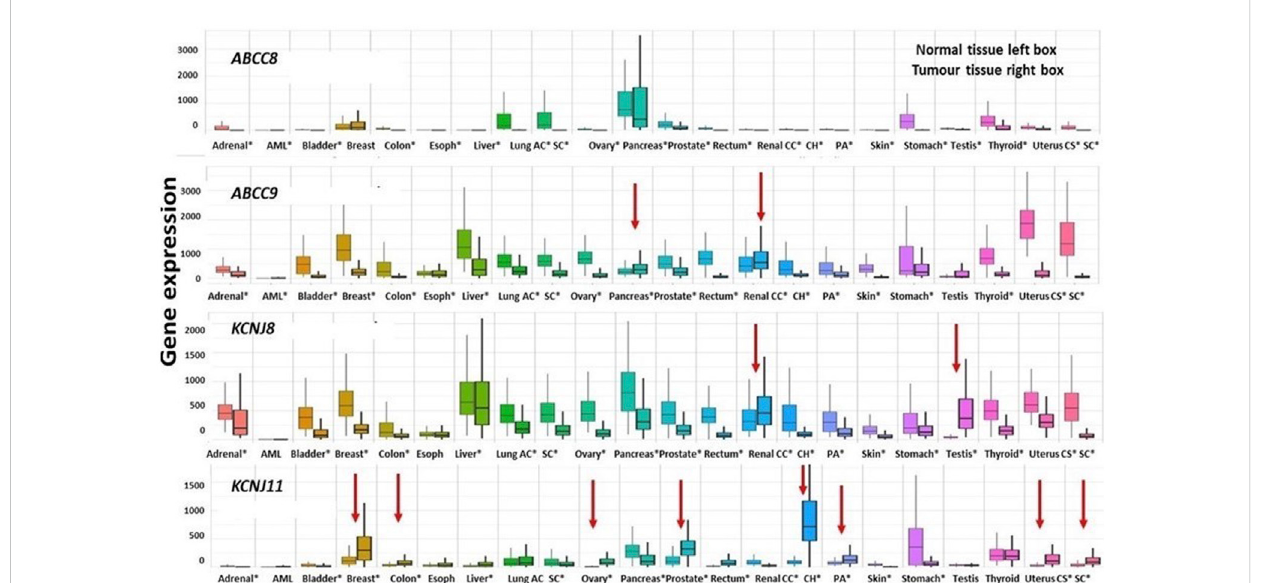
FIGURE 7 Differential expression genes are represented as boxplots of the ABCC8 , ABCC9 , KCNJ8 , and KCNJ11 genes differentially expressed in several common tumor types. From left to right, the boxplots report the differential expression of tumor tissues compared to normal tissues of the following tumors: adrenal cancer, acute myeloid leukemia (aml), bladder cancer, breast cancer, colon cancer, esophageal carcinoma, liver cancer, lung adenocarcinoma, lung squamous cell carcinoma, ovarian serous cystadenocarcinoma, pancreatic adenocarcinoma, prostate adenocarcinoma, rectum adenocarcinoma, renal clear cell carcinoma, kidney chromophobe, kidney renal papillary cell carcinoma, skin cutaneous melanoma, testicular germ cell tumors, thyroid carcinoma, uterine carcinosarcoma, and uterine corpus endometrial carcinoma. Signi fi cant differences are observed from a Mann – Whitney U test (* p < 0.01). The four genes were downregulated in the great part of the considered cancer types of exception made for those marked with red arrows which are